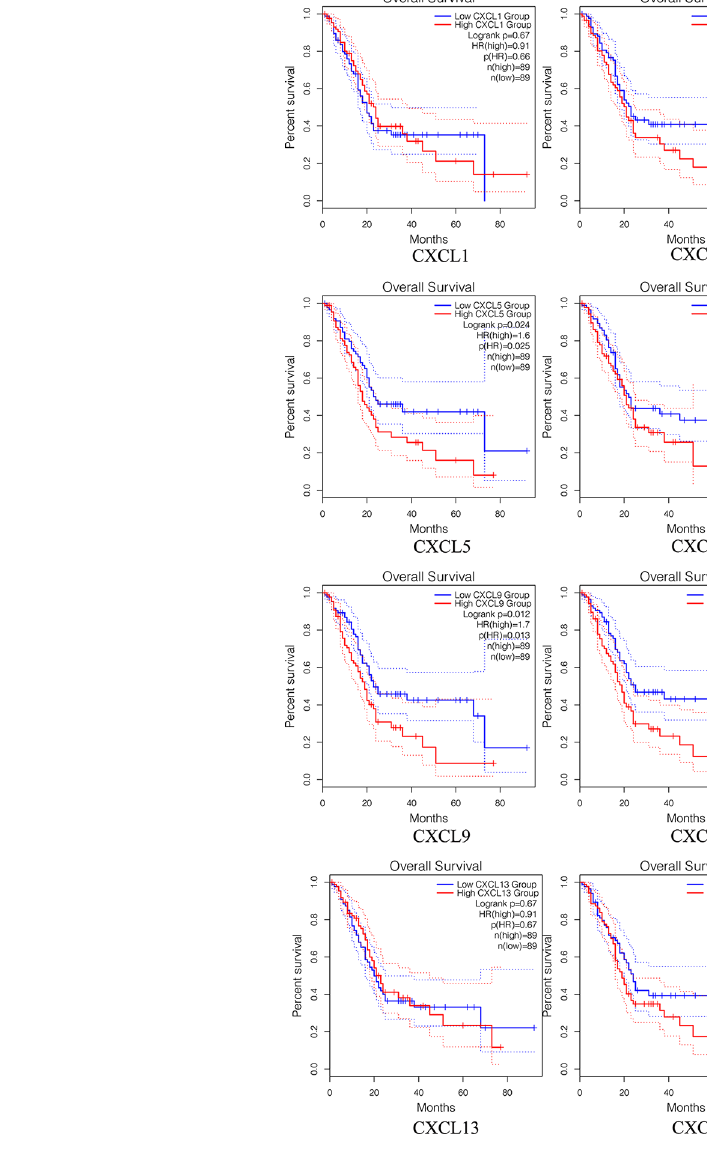
FIGURE 8 | The OS of single CXC chemokine in patients with PAAD